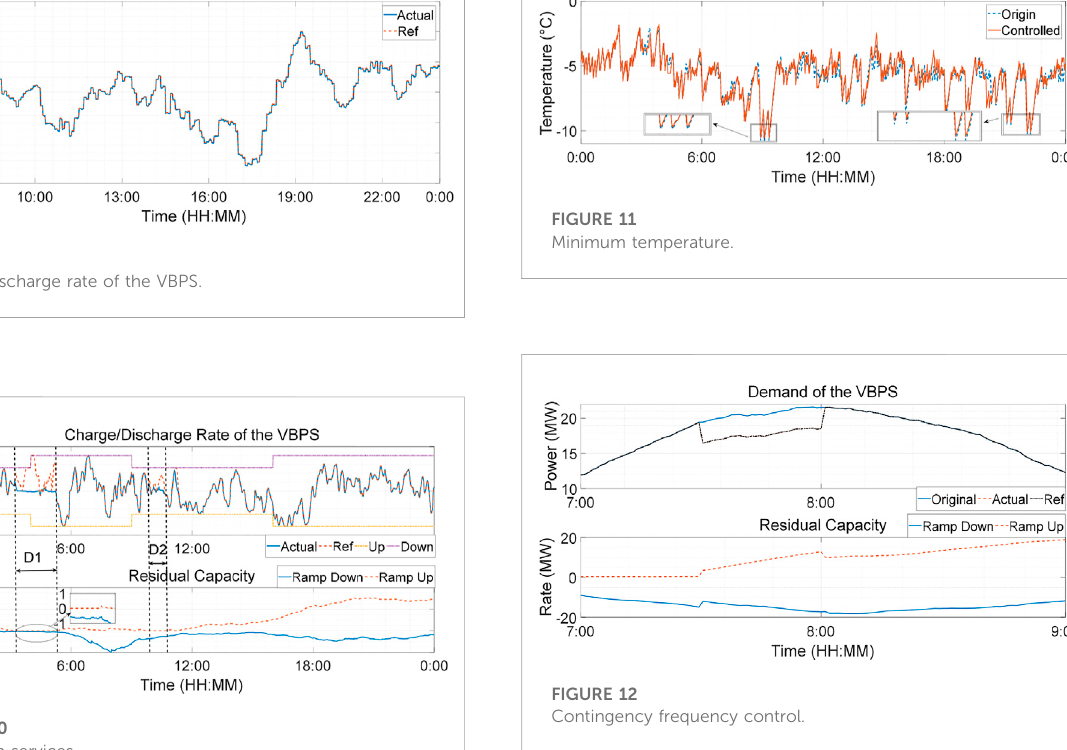
FIGURE 12 Contingency frequency